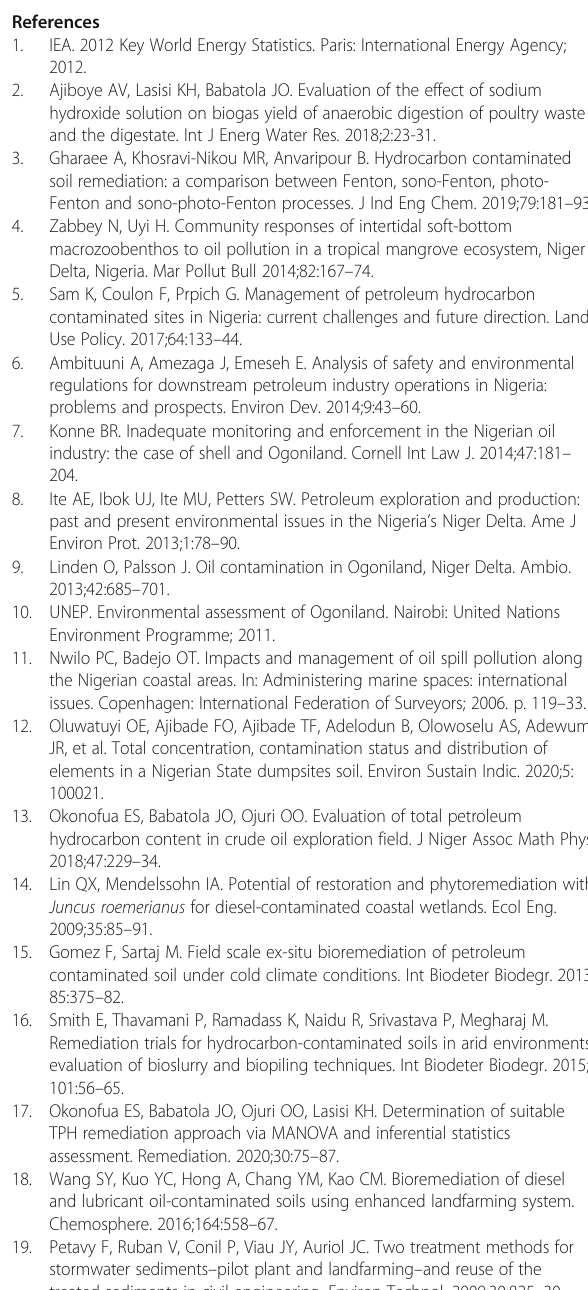
Additional file 1: Figure S1. Interphase of numerical optimization model for minimizing total petroleum hydrocarbon. Figure S2. Ramp solution of numerical